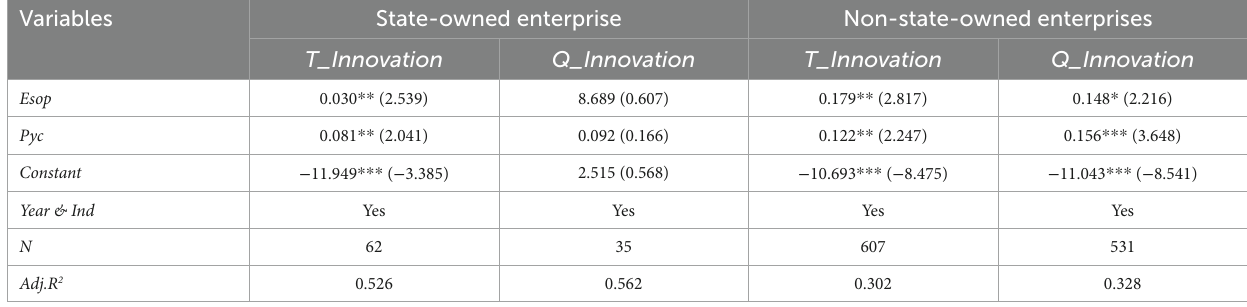
TABLE 12 The innovation effectiveness of employee equity incentive and executives’ psychological capital is affected by the nature of property rights.